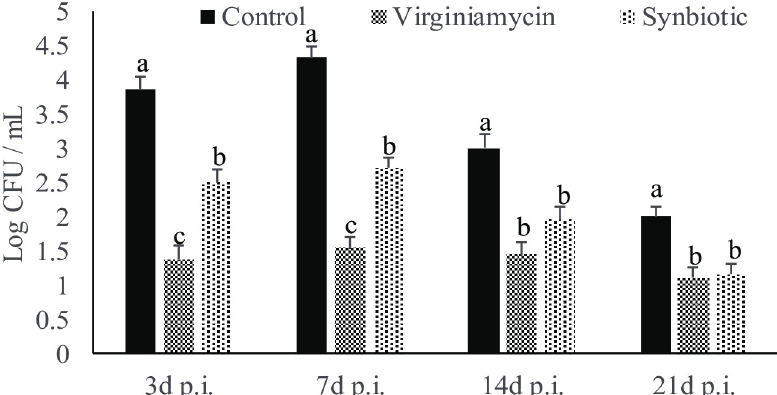
Fig 2. Effect of synbiotic supplementation on S . Enteritidis load in the cecal content post- Salmonella infection in broilers. Birds were fed either basal diet (Control) or supplemented with 20 mg/Kg feed Virginiamycin (antibiotic) or 0.05% synbiotic product from day-of-hatch through 42d of age. At 21 d of age, birds were challenged with 1 X 10 9 CFU of S . Enteritidis . At 3, 7, 14, and 21 d post-infection, cecal content were analyzed for S . Enteritidis load by real-time PCR collected and expressed as log values. Bars ( ± SEM) with no common superscript ( a, b, c ) differ significantly (P < 0.05). n = 8.